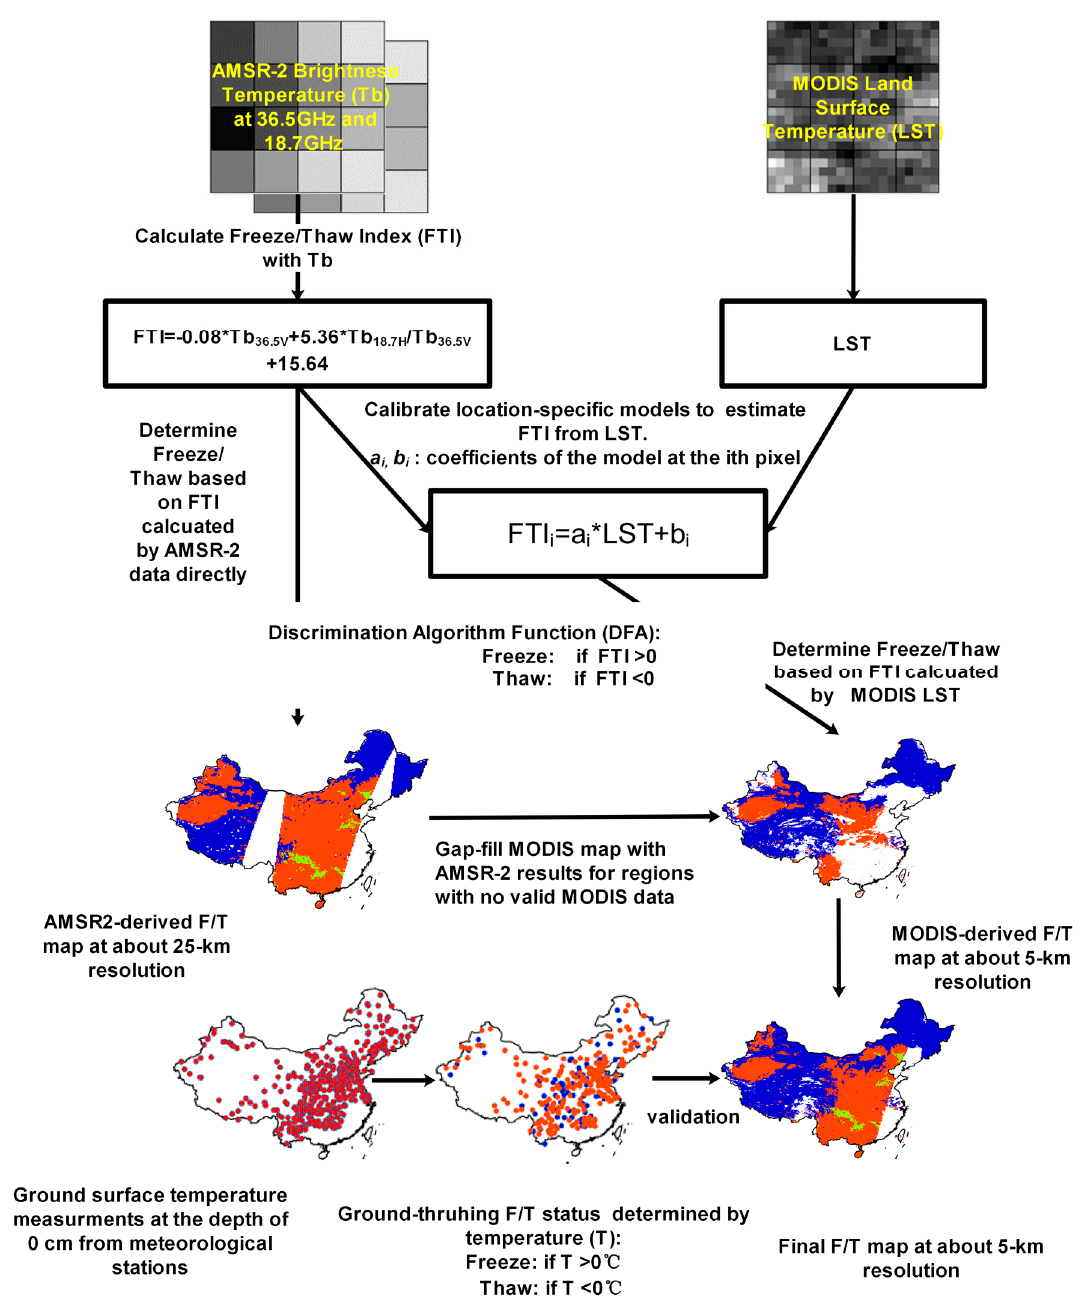
Figure 1. Flowchart of generating high-resolution F/T maps.